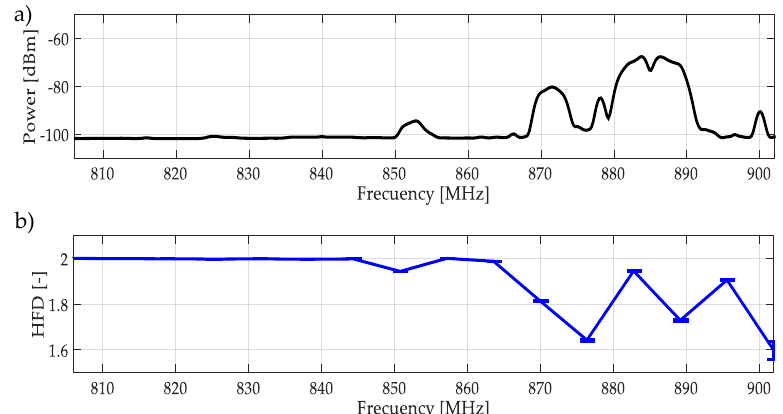
Figure 9. ( a ) The average of 300 multiband spectrum frames in the [806–902] MHz band. ( b ) The computed HFD (average) over these frames on uniform frequency windows.